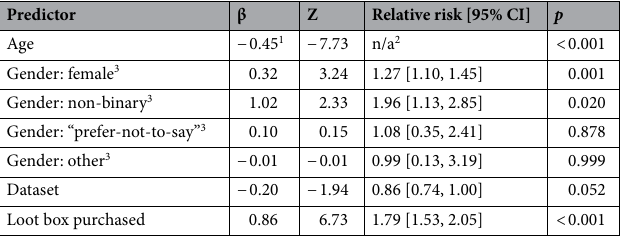
Table 1. Binomial linear regression results with age as a covariate and gender and dataset as factors. 1 Age converted to Z-score to generate β. 2 Relative Risk inappropriate for age as a continuous covariate. 3 Comparison group: male.